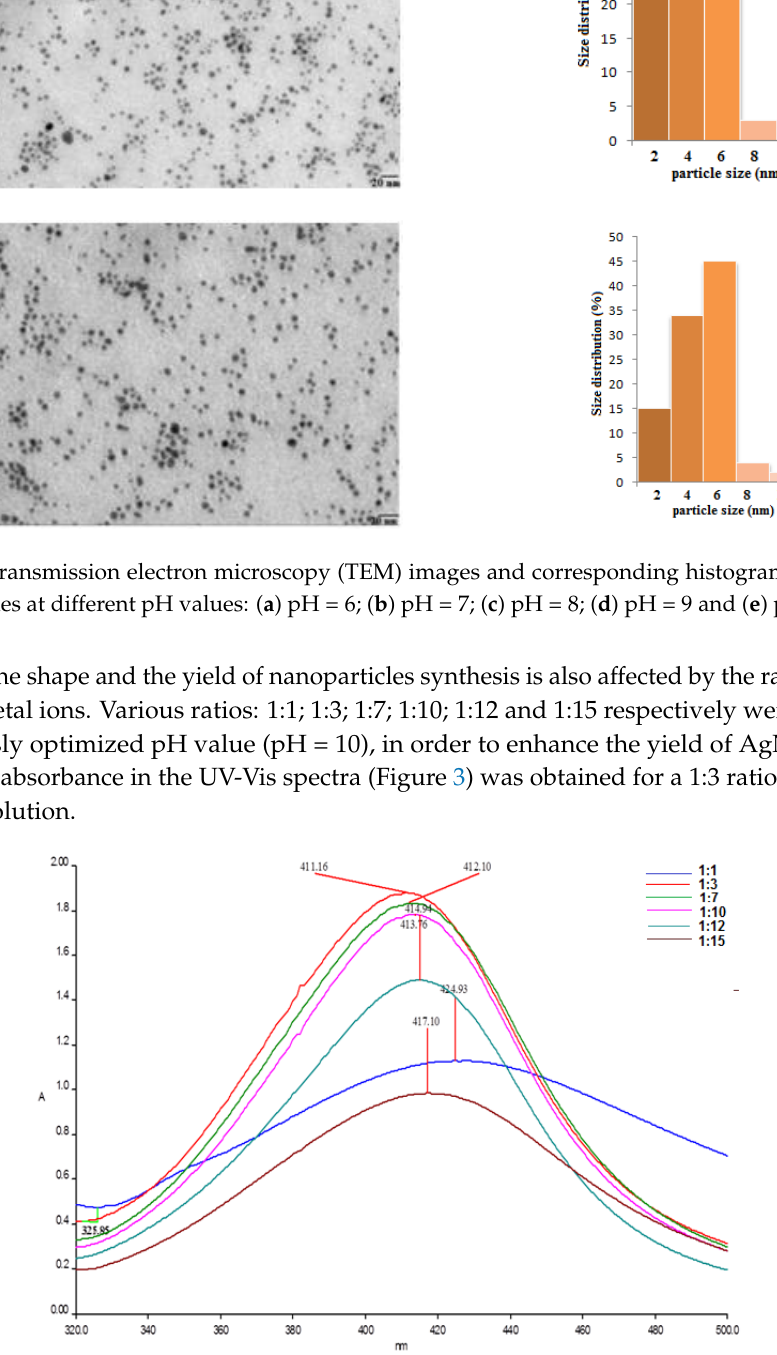
Figure 3. UV-Vis spectra of silver nanoparticles at different ratios fruit extract: silver nitrate solution.